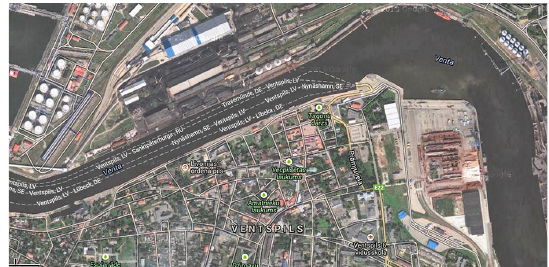
Fig. 2. A part of the Port of Ventspils in the Venta River area (width of the navigational channel – 80 m, ship turning basin – about 280 m in diameter)